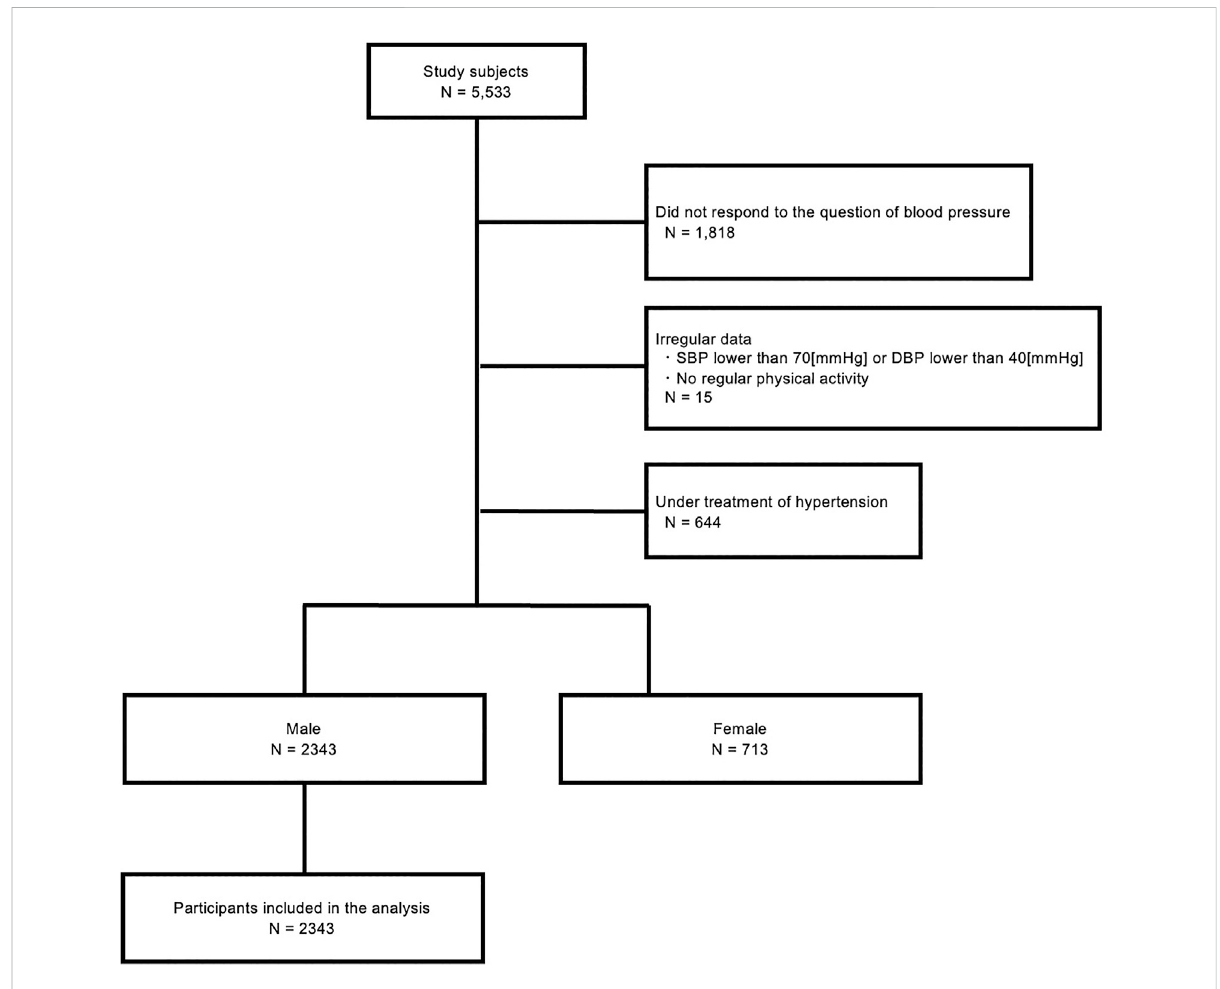
FIGURE 1 Flow design of the study participants.